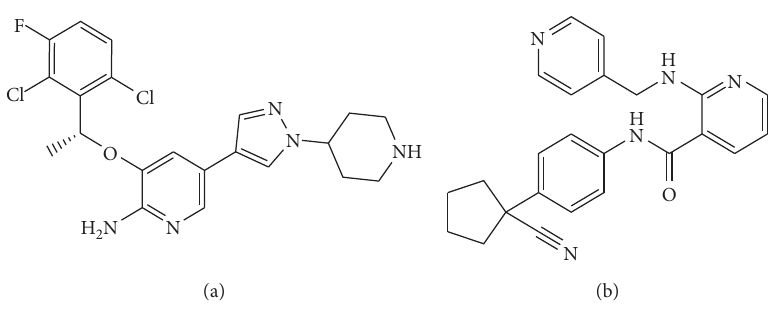
Figure 1: The chemical structures of (a) crizotinib and (b) apatinib